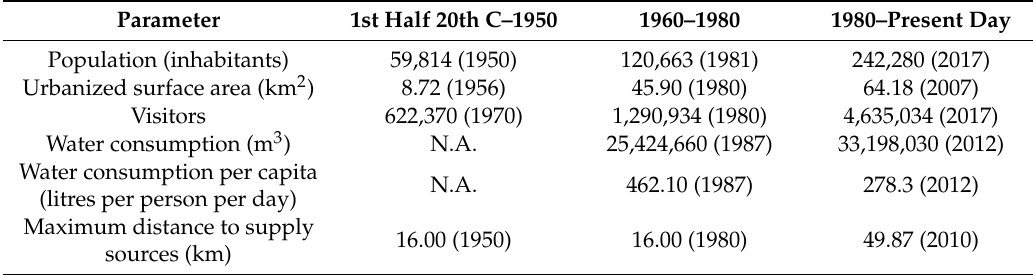
Table 1. Socio-territorial characterization and water supply in the Costa Brava region (years in brackets) for the three defined